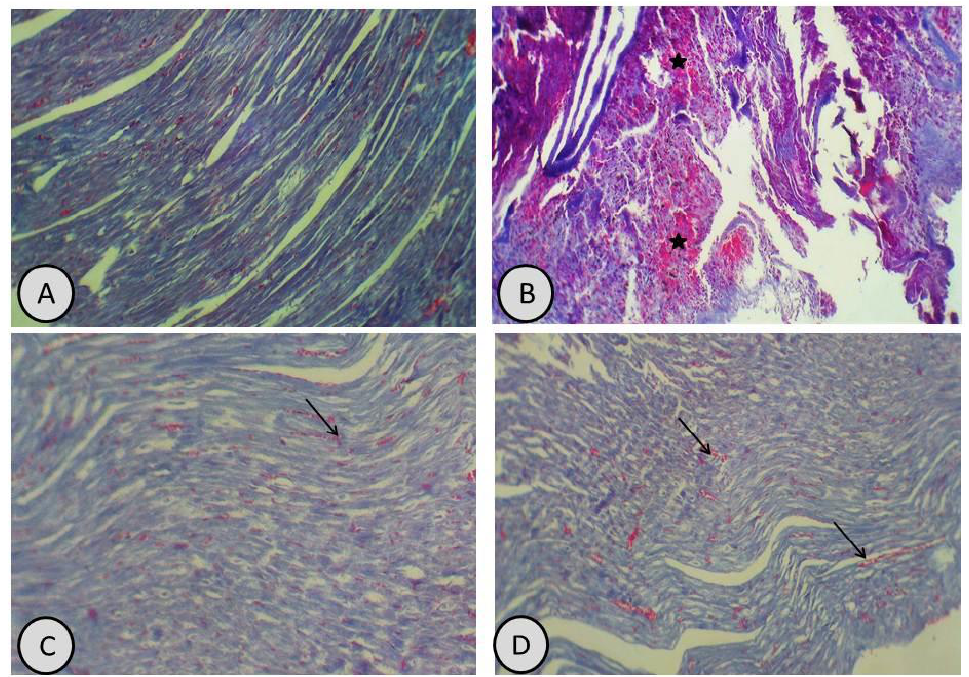
Figure 7. ( A ) Masson’s trichrome stain of the liver in control group showed normal amount of collagen fibres ( × 200); ( B ) Masson’s trichrome stain of the liver in CdCl 2 -treated group showed an increased amount of collagen deposition, compared with control rats ( × 200); ( C , D ) Masson’s trichrome stain of the liver in groups treated with R. damascena and combination of CdCl 2 and R. damascena showed normal amounts of collagen fibres in the hepatic tissues ( × 200).